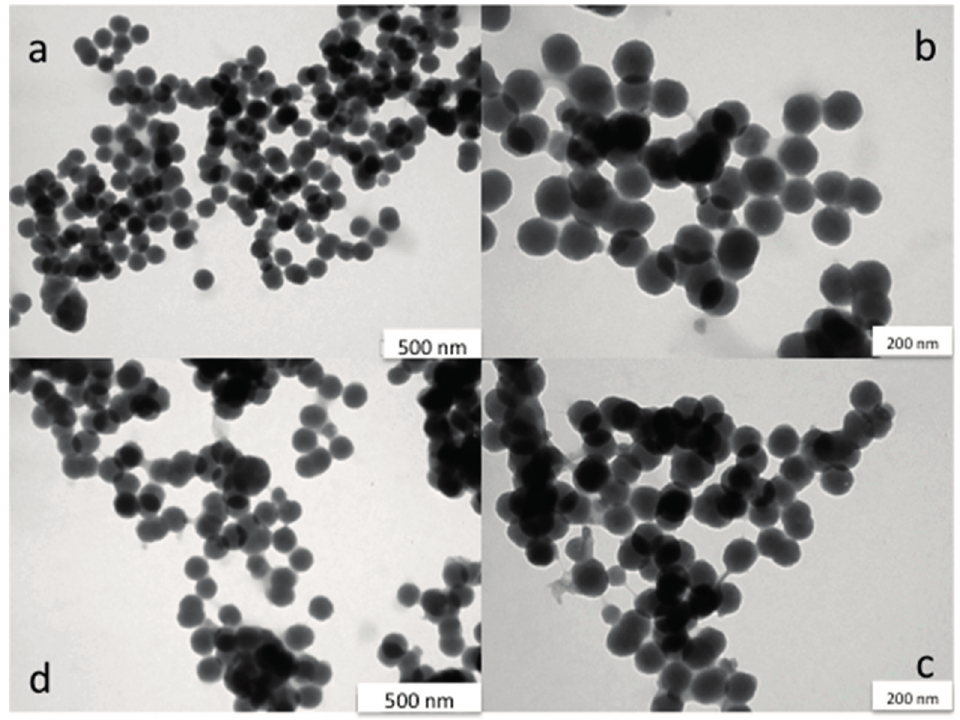
Figure 3. TEM image of Ru(bpy) 32+ -encapsulated silica nanoparticles. Figures 3a,b show unmodified nanoparticles, while Figures 3c,d show amino-modified nanoparticles. The scale bar in images a and d is 500 nm, and in b and c 200